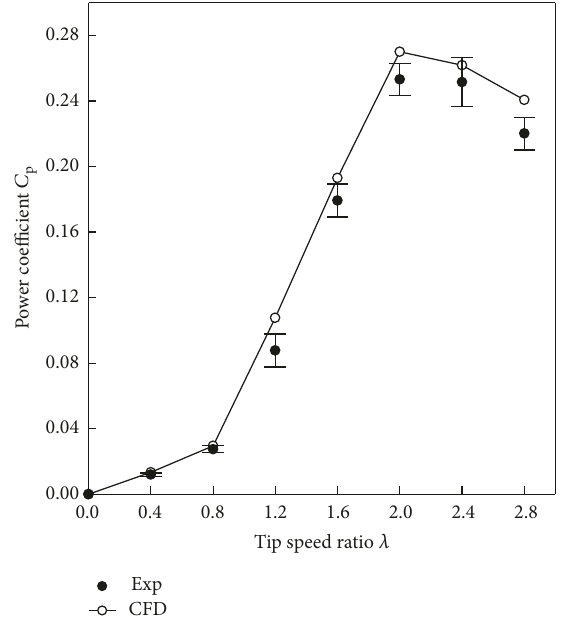
Figure 5: Power coefficients of wind turbine by simulation and